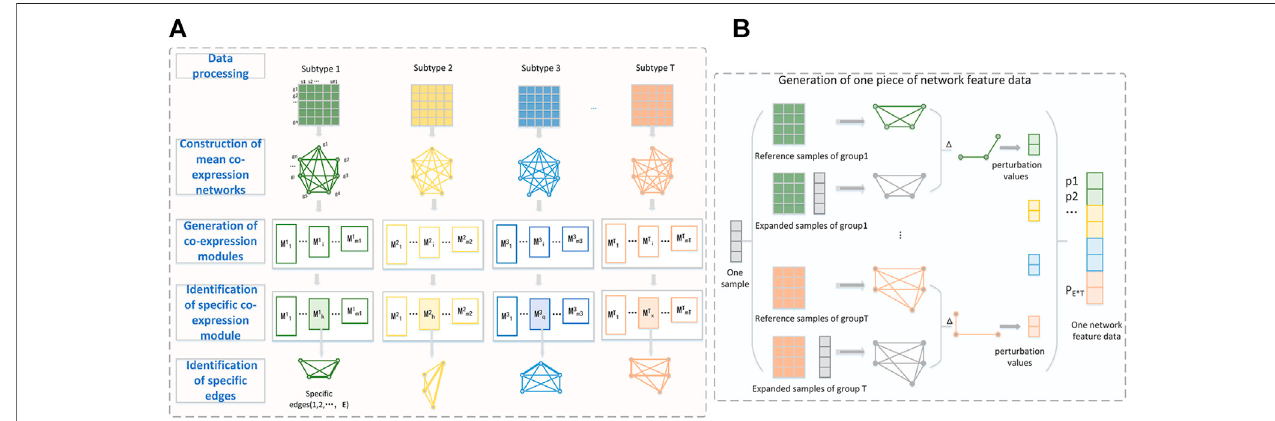
FIGURE 1 | (A) The work fl ow from data processing to speci fi c edges identi fi cation. Take four-subclass classi fi cation as an example. Each subtype is represented asageneexpressionmatrixwithngenesafterdataprocessing.WGCNAisusedtodividewholegenesetintodifferentco-expressionmodules.Thespeci fi cedgesofone subtype are extracted from the speci fi c module of their subtype. The perturbation of these speci fi c edges (gene pairs) is used to generate network features data. (B) Detailed process of generating one piece of network feature data. The perturbation values of a sample are the difference of speci fi c edges between expanded network and the reference network.